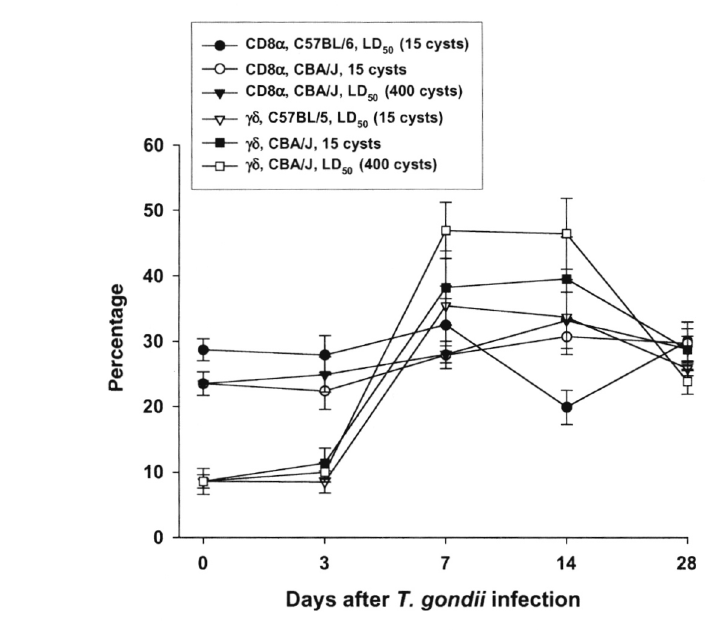
Fig. 4. - The kinetics of phenotypic changes of splenocytes from C57BL/6 and CBA/J mice orally infected with the 76K strain of T. gondii. Splenocytes were stained with FITC-conjugated anti­ mouse CD8a, y δ TCR mAb, and then analyzed by FACScan. Data shown are the mean ± SD of one of two separate experiments (n = 5 for each value at all time point). The experiment was repeated two times with essentially similar results.